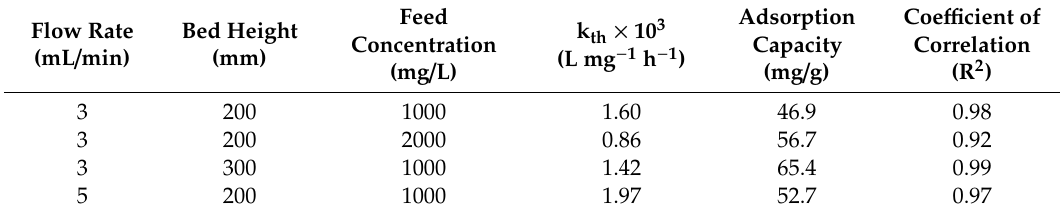
Table 5. Thomas model constants for adsorption of sulfate onto